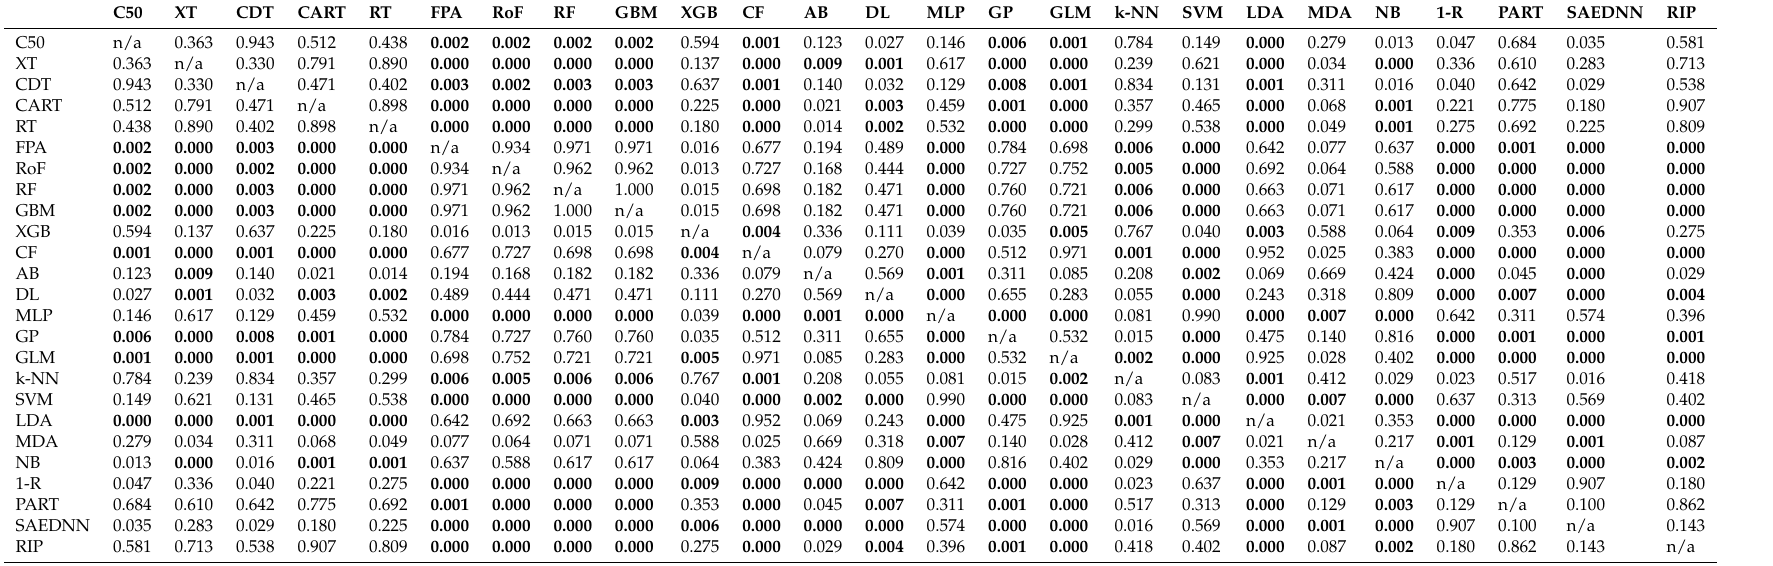
Table 2. Results of post-hoc test using Finner correction w.r.t 10cv (bold indicates significance at p -value <